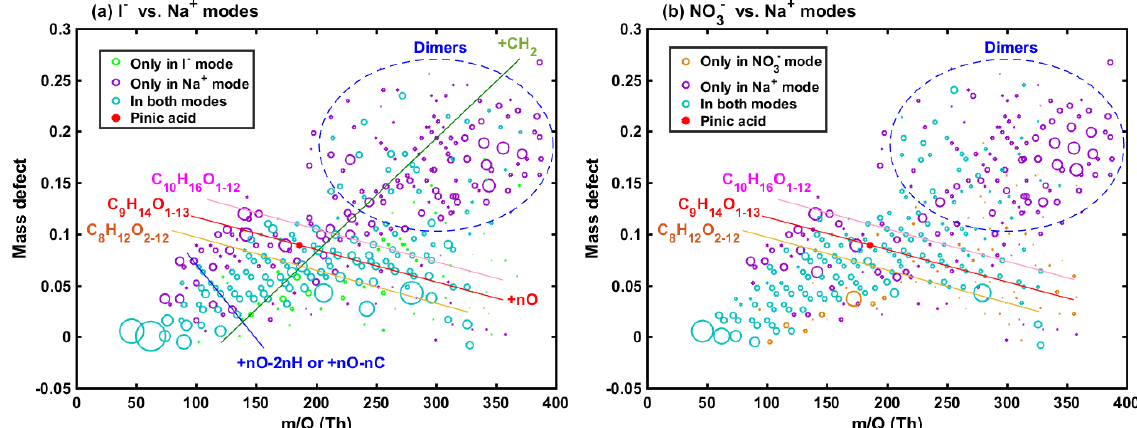
Figure 10. Comparisons of mass defect plots derived in (a) I − and Na + modes and (b) NO − in a steady-state chamber. To compare the mass defect plot obtained in two different ion modes, the reagent ions in observed clusters are excluded for the mass defect calculation, and the signals are normalized to the corresponding pinic acid intensity in each mode (see text for details). The purple circles do not necessarily mean such ions were undetected in the negative mode as they may have very small signal ( < 5cps) and be excluded from the high-resolution